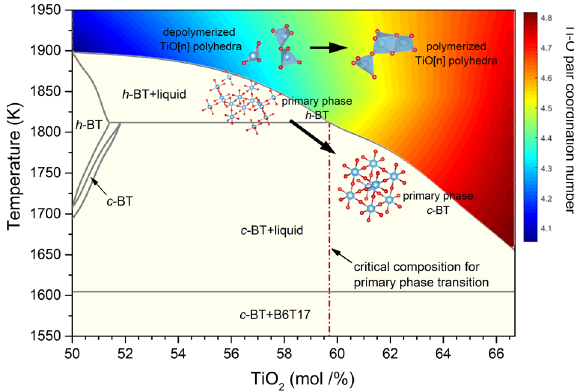
Fig. 9 Parallel effect of anomalous structure transition of molten BT near T c → h with increasing TiO 2 content in equilibrium state. Variation of structural polymerization (demonstrated as mean Ti – O coordination number) in (1 − x )BaO − x TiO 2 ( x from 50% to 66.67%) melt with both composition and temperature. Phase diagram of BaO – TiO 2 binary system in the composition range of 0.5 ≤ x ≤ 0.6667 is